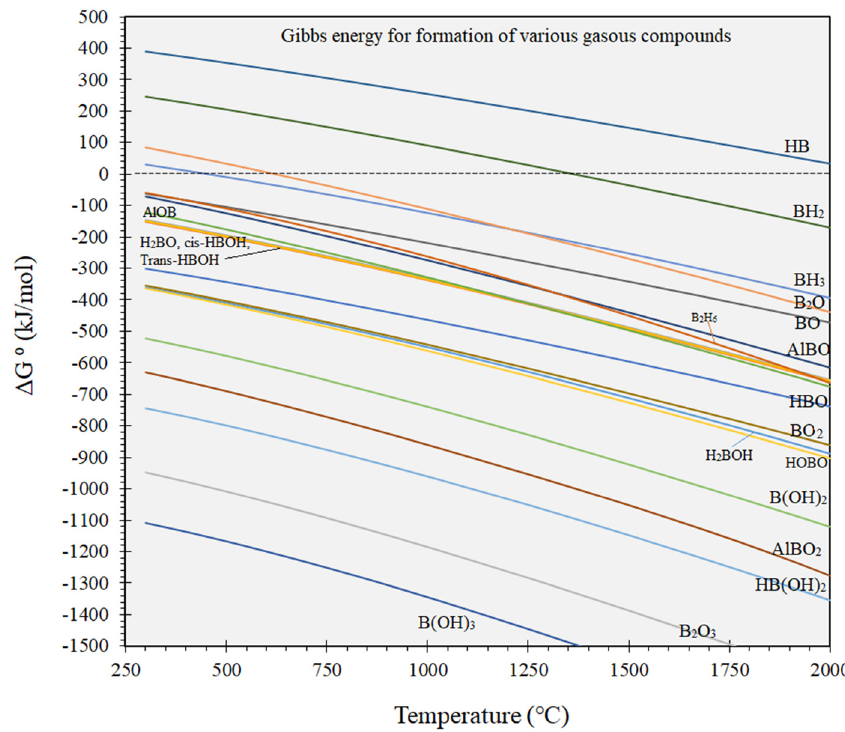
Figure 1: The Gibbs energy for formation of the gaseous compounds in H – Al – B – O system calculated by M06 -